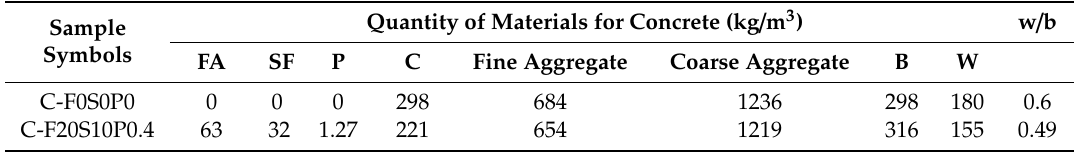
Table 4. The mix proportions of concrete specimens.